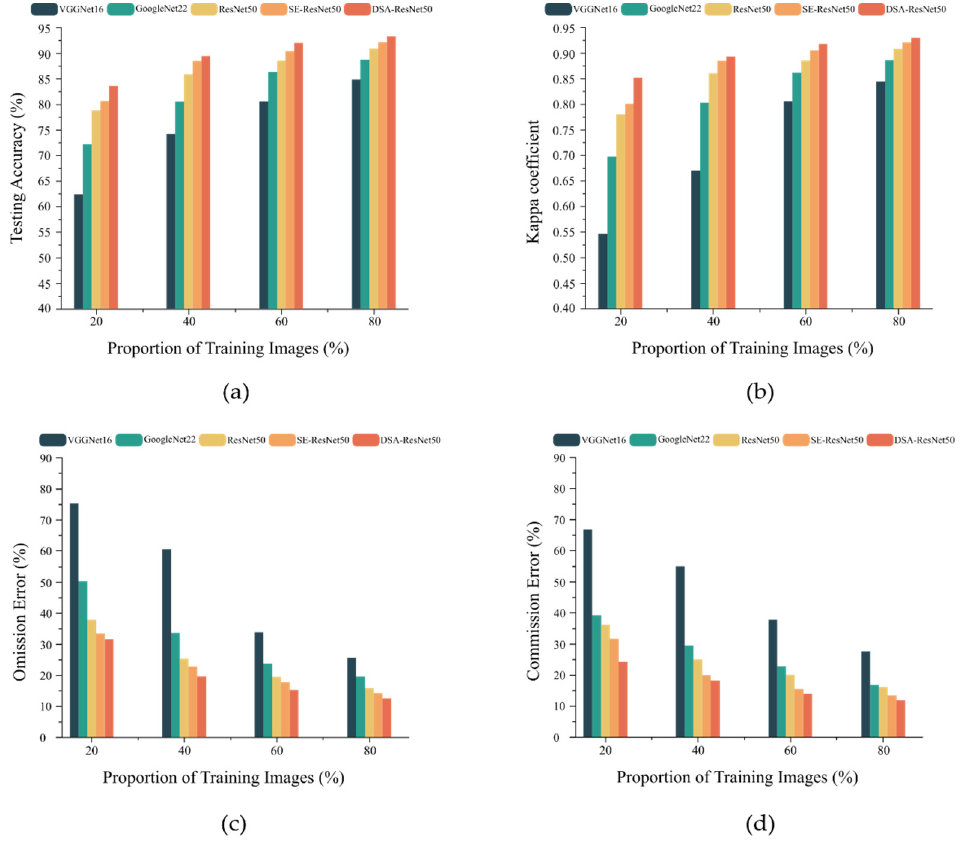
Figure 6. Performances of the existing models (VGGNet16, GoogleNet22, ResNet50, and SE-ResNet50), and DSA-ResNet50 trained with four proportions (20%, 40%, 60%, and 80%) of training images. ( a ) Testing accuracy; ( b ) kappa coefficient; ( c ) omission error; and ( d ) commission error.